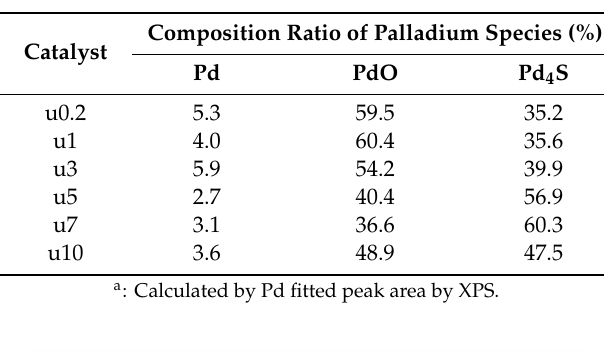
Table 3. Palladium species content of used catalysts with di ff erent H 2 S concentration a . Catalyst